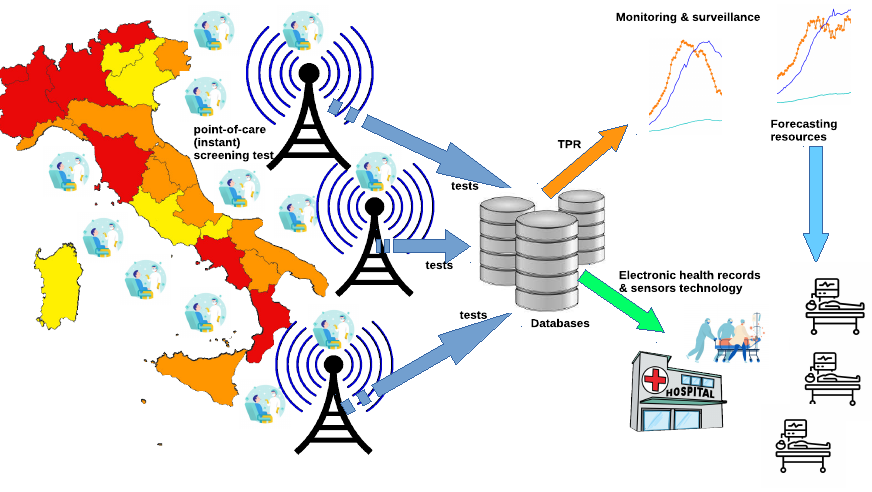
Figure 4. Developing point-of-care (instant) screening tests for COVID-19: data collection, sensors technology, TPR calculation, and information